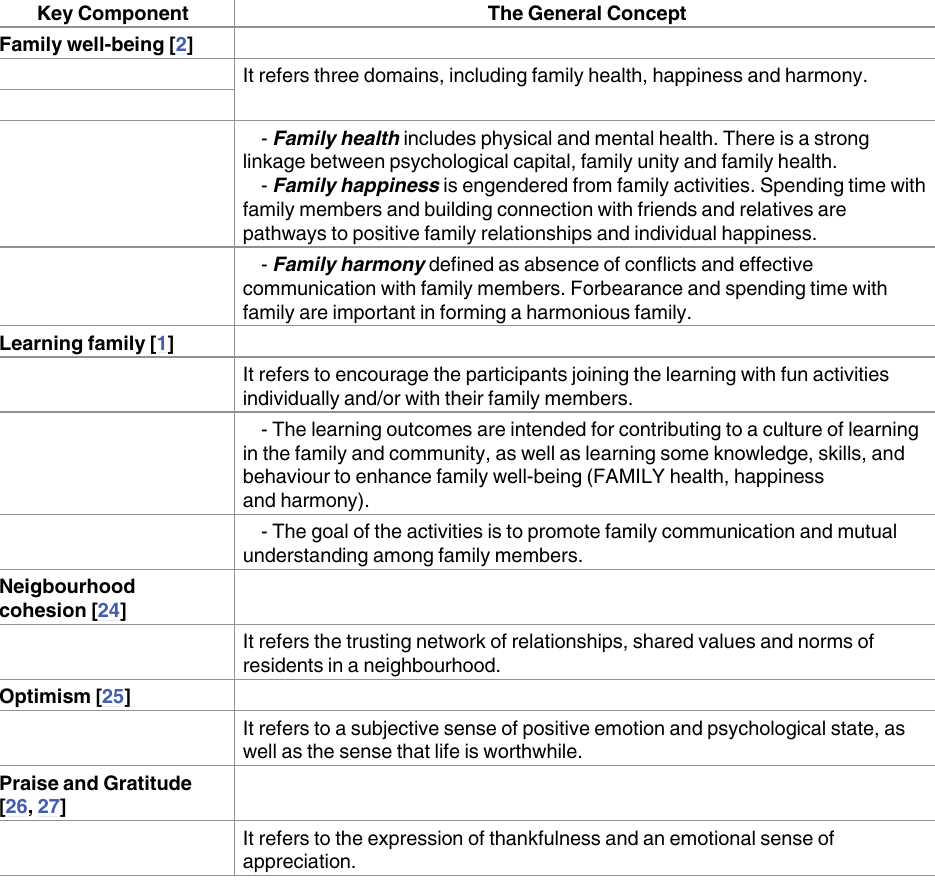
Table 2. Operational definitions of the key concepts utilized in the Learning Family